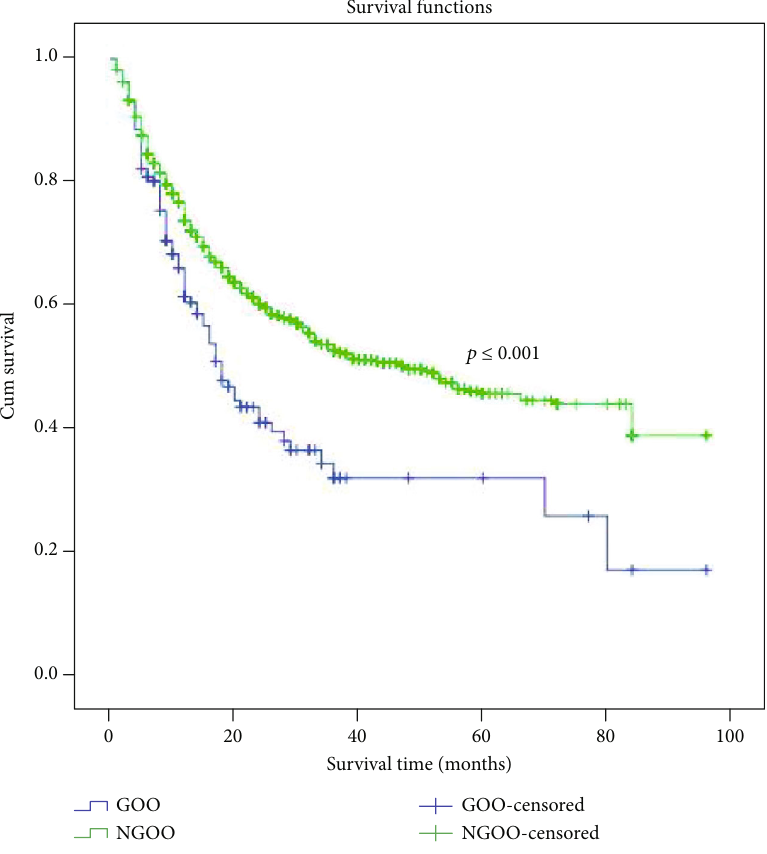
Figure 1: Kaplan-Meier survival curves for 1564 gastrectomy patients according to GOO. The prognosis of gastric cancer patients with GOO was poorer than that of patients without GOO ( p ≤ 0 : 001 ). The fi ve-year survival rate was 25.8% and 45.9% among patients with and without GOO,